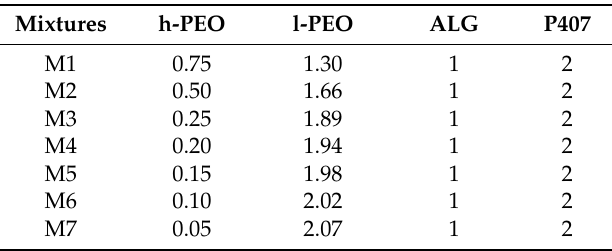
Table 1. Composition of ALG (alginate)/h-PEO (high MW poly(ethylene oxide))/l-PEO (low MW poly(ethylene oxide)) mixtures, expressed as % w / w .